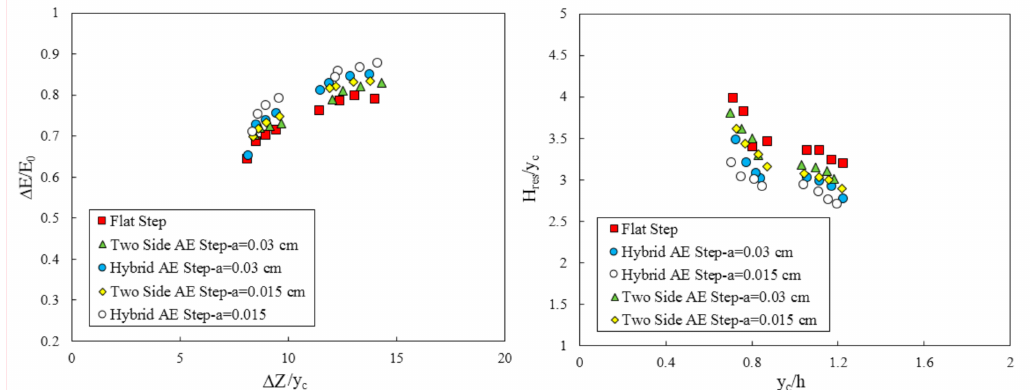
Figure 16. The effect of the appendance elements height on the rate of energy dissipation and the residual head.